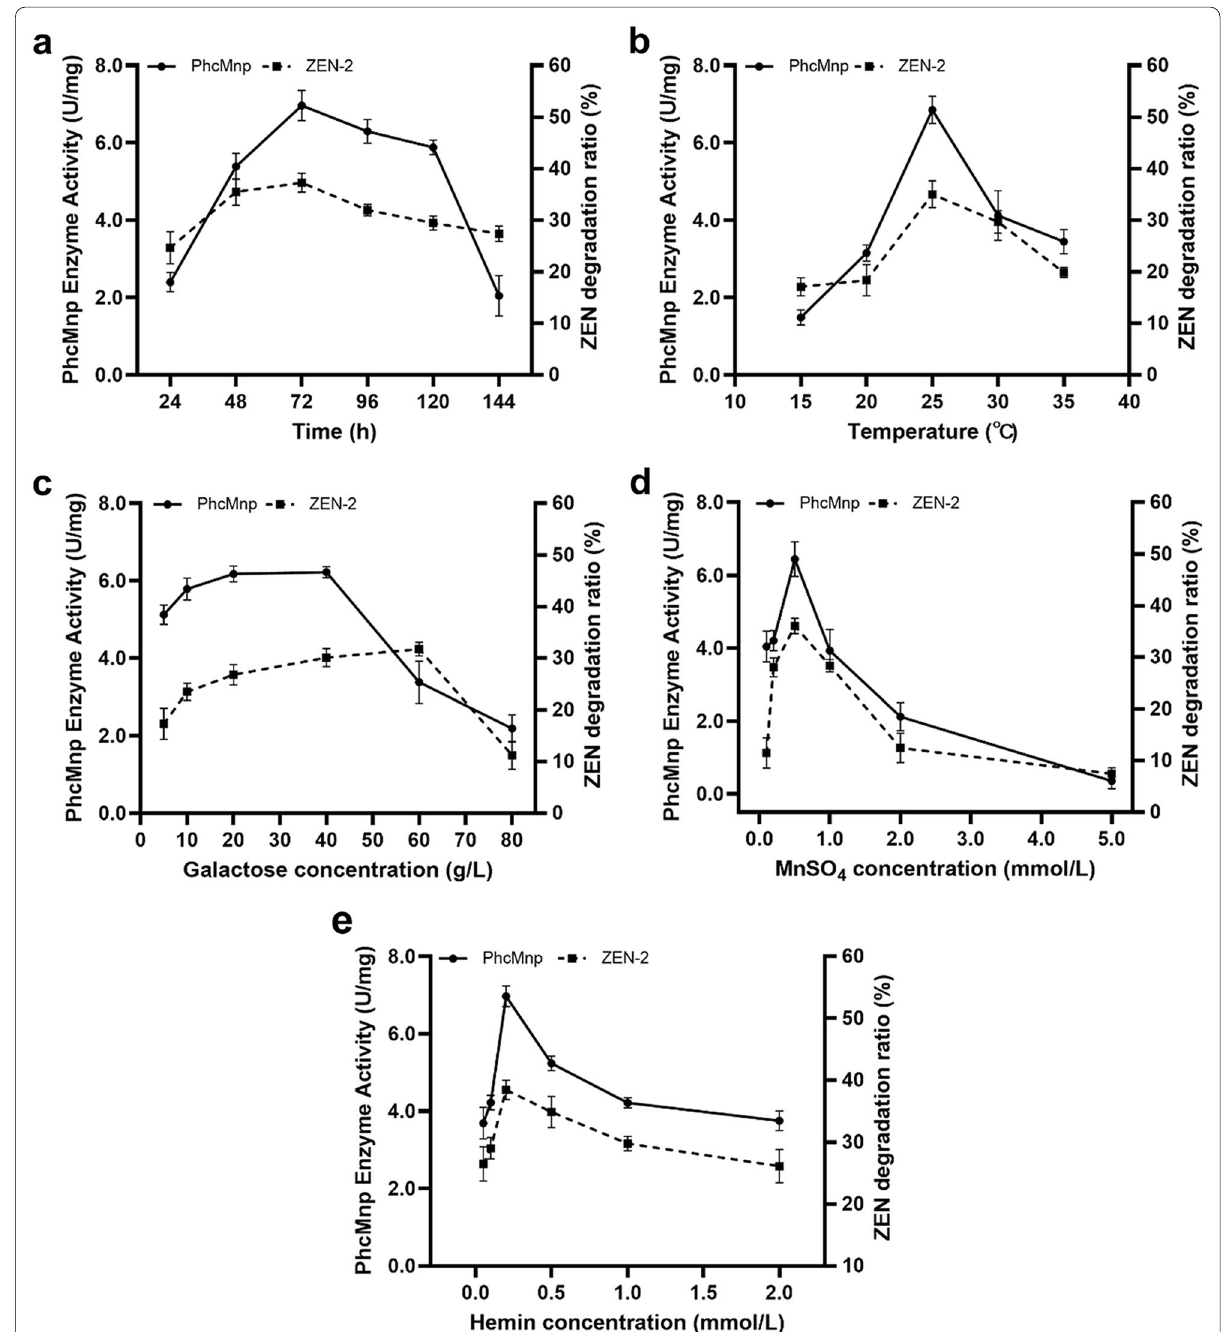
Fig. 3 Enzyme activity of PhcMnp and ZHD101.1 expressed by ZPF1 under different induction conditions. The left axes were the PhcMnp enzyme activities, and the right axes were the degradation ratios of ZEN (by ZHD101.1). a–e were the effects of time, temperature, galactose concentrations, MnSO 4 concentrations and hemin concentrations on the enzyme activities of the